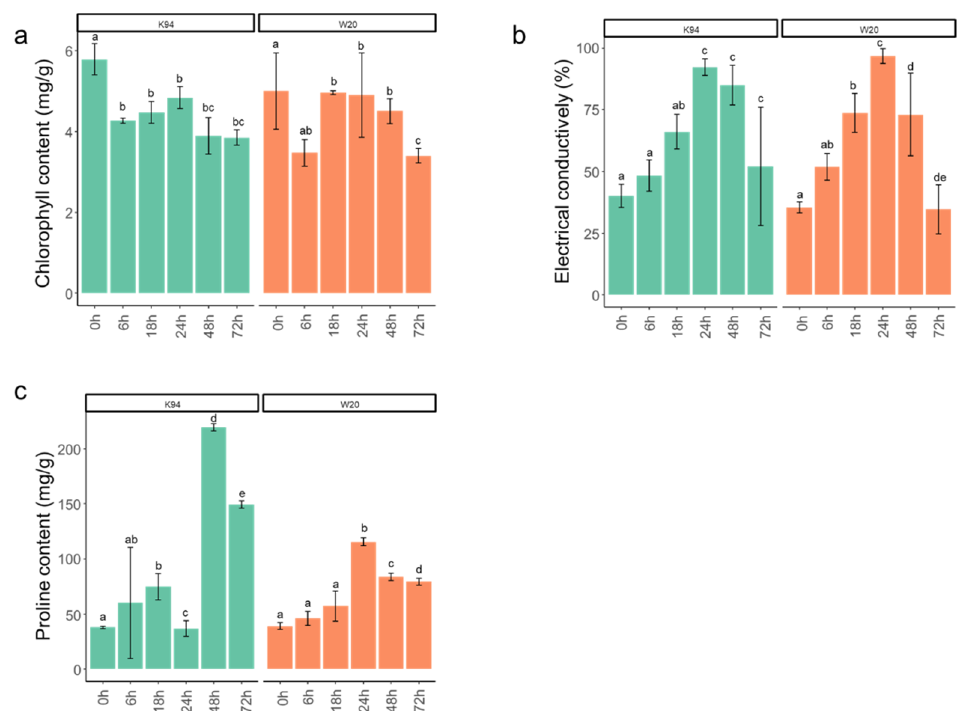
Figure 1. Physiological diversity variations in the response to salt stress in cannabis. ( a ) The diversity in chlorophyll contents; ( b ) the diversity in electrical conductivity; ( c ) the diversity in proline contents. Green represents the K94 variety; orange represents the W20 variety. The letters at the top of the histogram stand for the variation comparisons with the data before and/or after treatment: the same letters stand for data with no significant differences ( p ≤ 0.05); two different letters represent differences in the data reaching extremely remarkable level ( p ≤ 0.01).